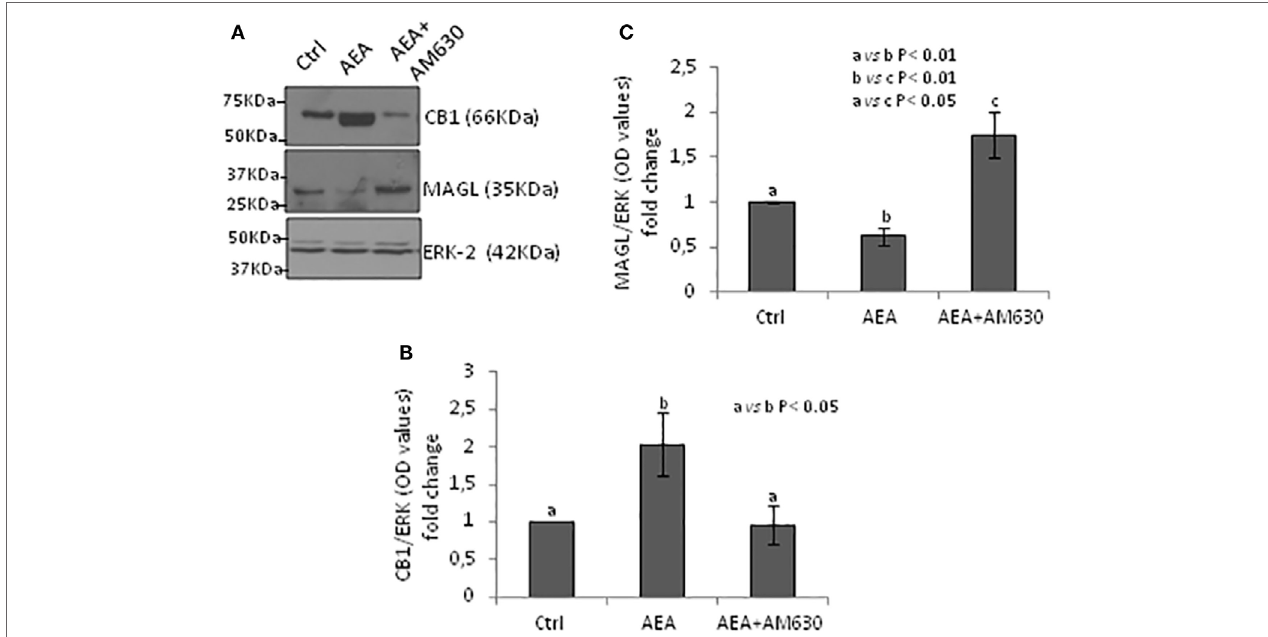
FigUre 6 | Responsiveness of monoacylglycerol-lipase (MAGL) to CB1/CB2 receptors. Western blot analysis of CB1 and MAGL in CB1 + / − testes exposed to vehicle or AEA ± AM630 (a) . CB1 amount was quantified by densitometry analysis, normalized against ERK1/2 signals, and expressed in OD values as fold change (B) . MAGL amount was quantified by densitometry analysis, normalized against ERK1/2 signals, and expressed in OD values as fold change (c) . All data are reported as mean ±